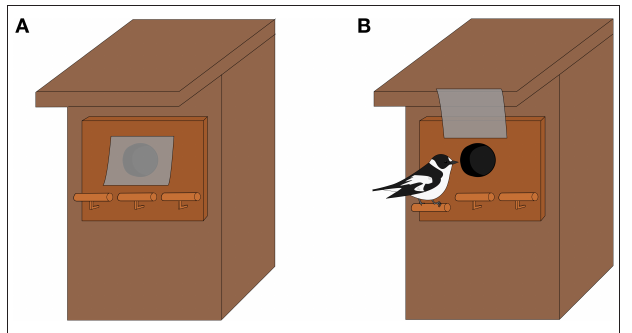
FIGURE 1 | Problem-solving task at the nest used to measure flycatchers’ learning ability. (A) The entrance hole is closed by a plastic door but (B) can be opened by the parent (here a male) to enter and feed the nestlings by perching on one of the levers, here the left one. The position of the opening lever, either left or right, was randomized between pairs. See text for the measure of learning performance extracted from the problem-solving